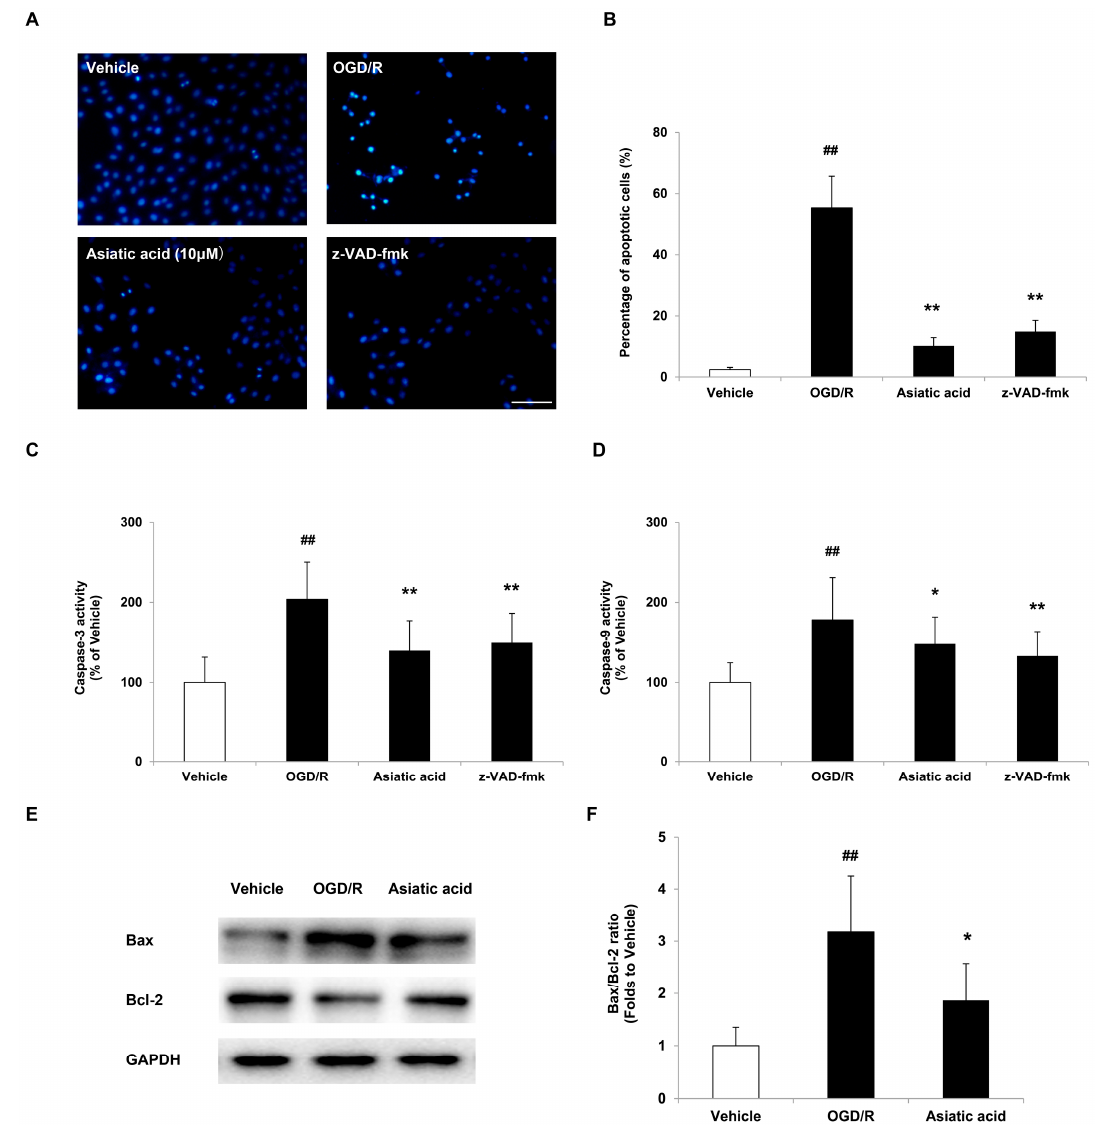
Figure 2. Asiatic acid attenuates apoptosis in H9c2 cardiomyocytes after oxygen-glucose deprivation/ reoxygenation (OGD/R). ( A ) Nuclear condensation was visualized by Hoechst 33258 staining. Nuclei showing clearly bright chromatin condensation and/or fragmentation were regarded as apoptotic cells; ( B ) Apoptotic cells were counted and expressed as the percentage of total cell count; ( C ) Measurement of caspase-3 activity; ( D ) Measurement of caspase-9 activity; ( E ) Immunoblots of Bax, Bcl-2 and glyceraldehyde-3-phosphate dehydrogenase (GAPDH) by Western blot assay; ( F ) Semi-quantitative analysis of protein levels. ## p < 0.01 vs. the vehicle group; * p < 0.05, ** p < 0.01 vs. the OGD/R group. Scale bar, 100 μ m.